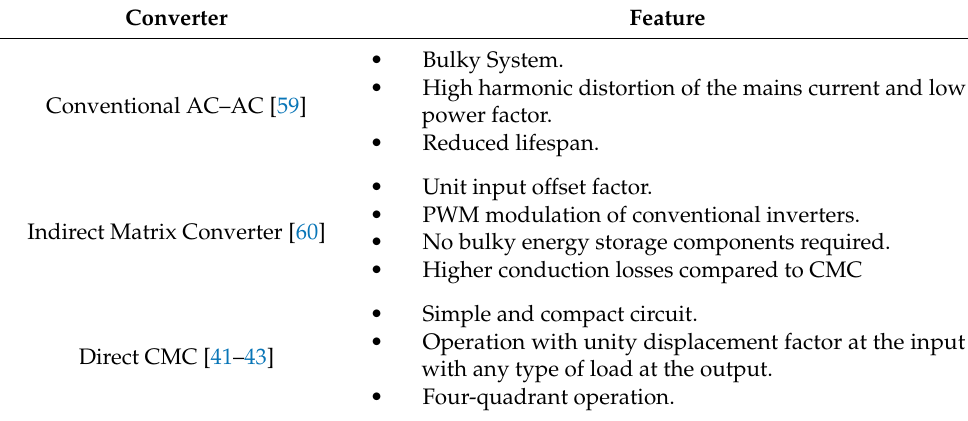
Table 3. Main characteristics of low-power voltage